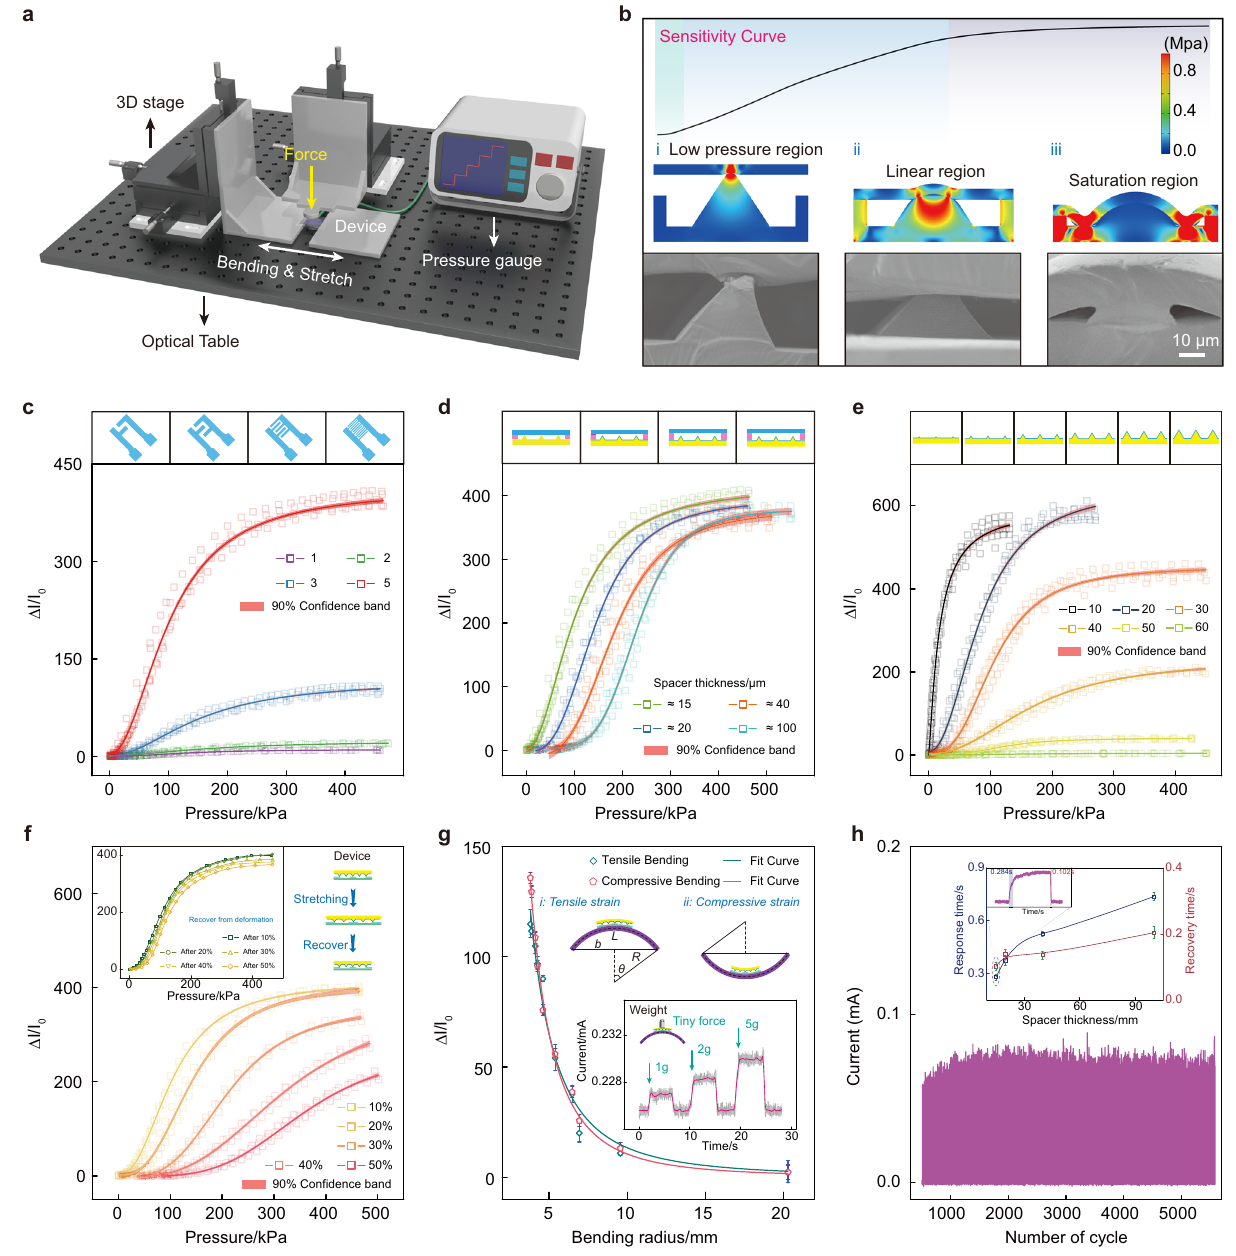
Fig. 3 | Pressure sensing performance of the ultrathin sensor. a Schematic dia- gram of the experimental setup for pressure sensing. b Sensitivity curve of the sensor (top); Simulation of stress distribution of the prslPDMS layer and micro- structured PDMS under externalpressure (middle); Cross-sectionalSEM images of the sensor underdifferentpressures (bottom).Relativechange in current( Δ I / I 0 )of the sensors with different interdigital Ag NFs electrodes ( c ), spacer layer thickness